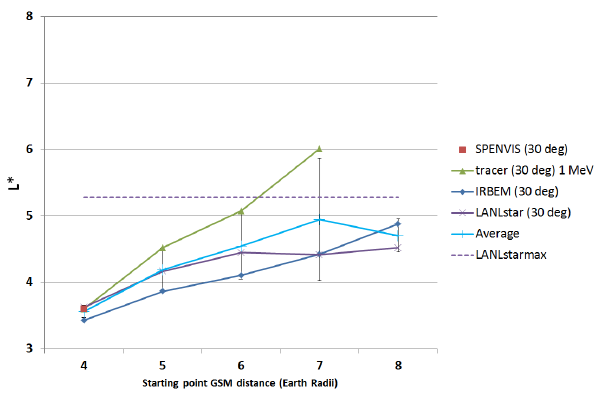
Figure 9. Calculations of L ∗ as a function of initial distance (in R E ) at 00:00MLT, for an initial pitch angle of 90 ◦ during disturbed solar wind conditions. Error bars represent the standard deviation between results from the various